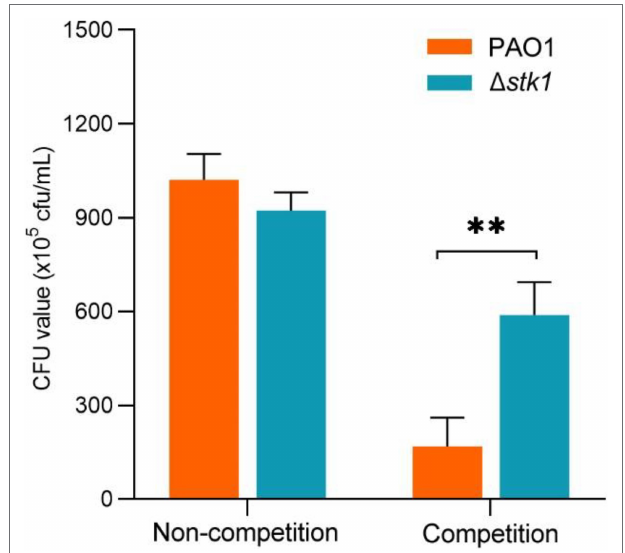
FIGURE 10 | stk1 deletion provides a growth competition advantage against Escherichia coli K12. Δ stk1 or wild-type PAO1 was mixed 1:1 with E. coli K12 as the competition group. Additionally, the growth of PAO1 and Δ stk1 in liquid LB medium alone was used as the noncompetition control. After incubating at 37 ° C with shaking for 6 h, the cultures were spread on selective cetrimide agar plates at an appropriate dilution ratio. The CFU values were determined by counting the bacterial colonies. The bars represent the mean CFU value (SD) from three independent experiments ( ** p <